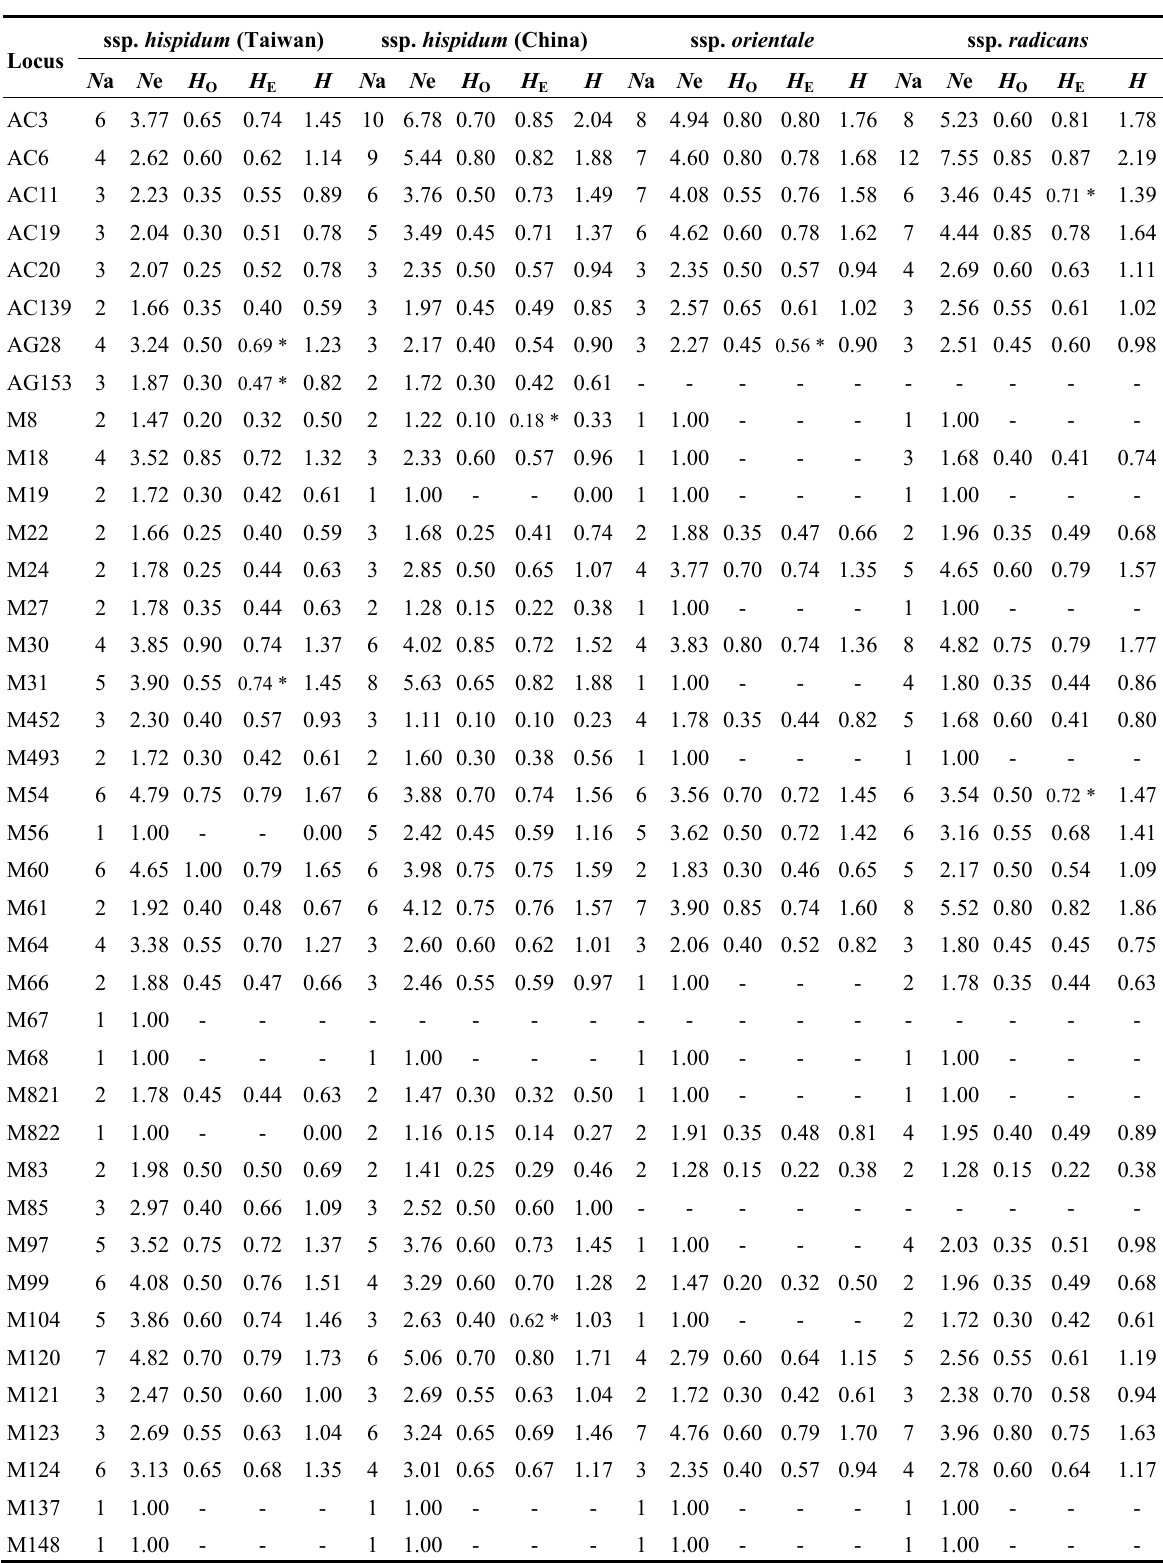
Table 3. Average genetic diversity for three subspecies of Toxicodenderon radicans based on the 42 newly developed microsatellites. For each locus, number of alleles ( N a), effective number of alleles ( N e), observed heterozygosity ( H Shannon’s information index ( H ) are